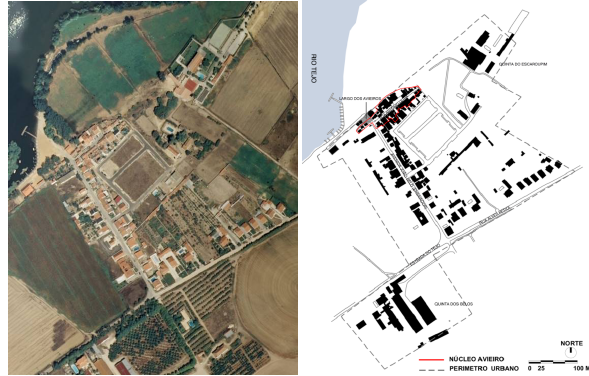
Figure 3: Urban morphology of vernacular village of Escaroupim (IGP, 2007; Almeida,